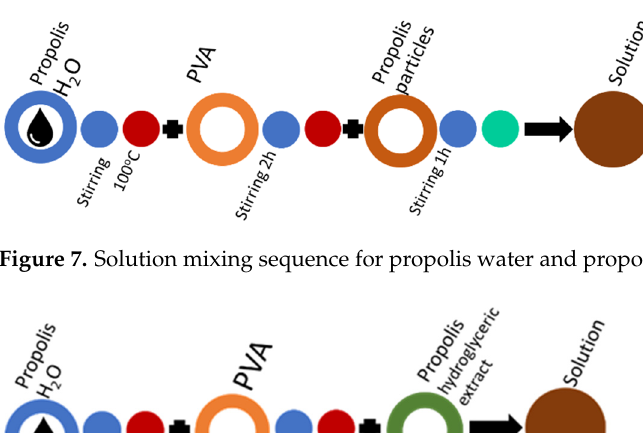
Figure 6. Solution mixing sequence for propolis water integration into electrospinning solution.